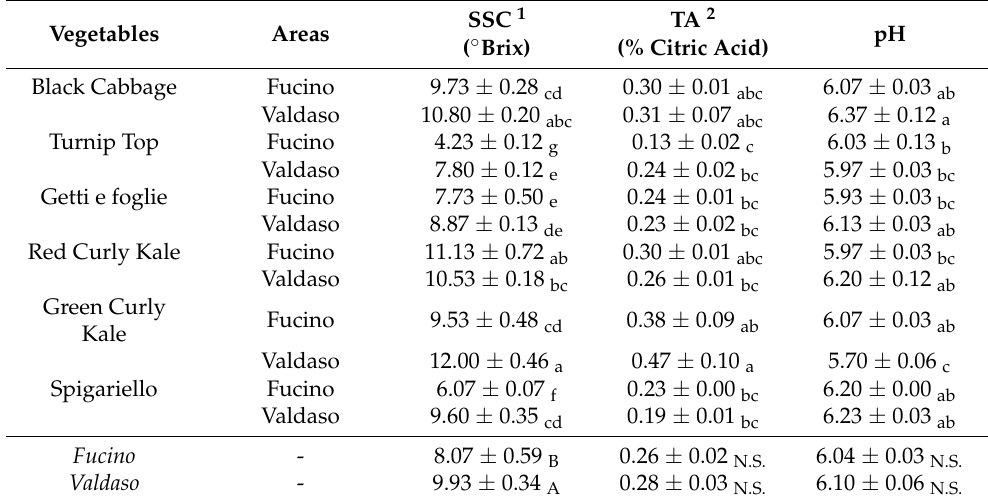
Table 5. Average of sensorial data collected during the 2nd year of trials in different environments (Fucino vs. Valdaso